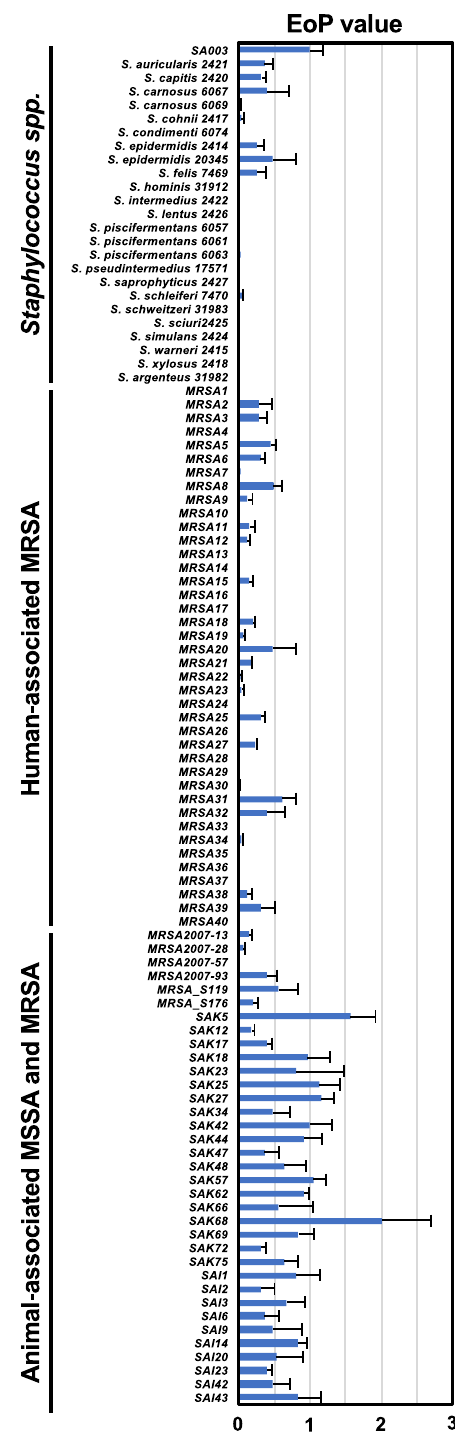
Figure 2. EoP of ΦSA012 against Staphylococcus spp. strains and S. aureus clinical isolates. SA003 was assigned as the control host against ΦSA012. EoP values are indicated as fold changes in the effect on SA003 and are presented as means ± SD (n =